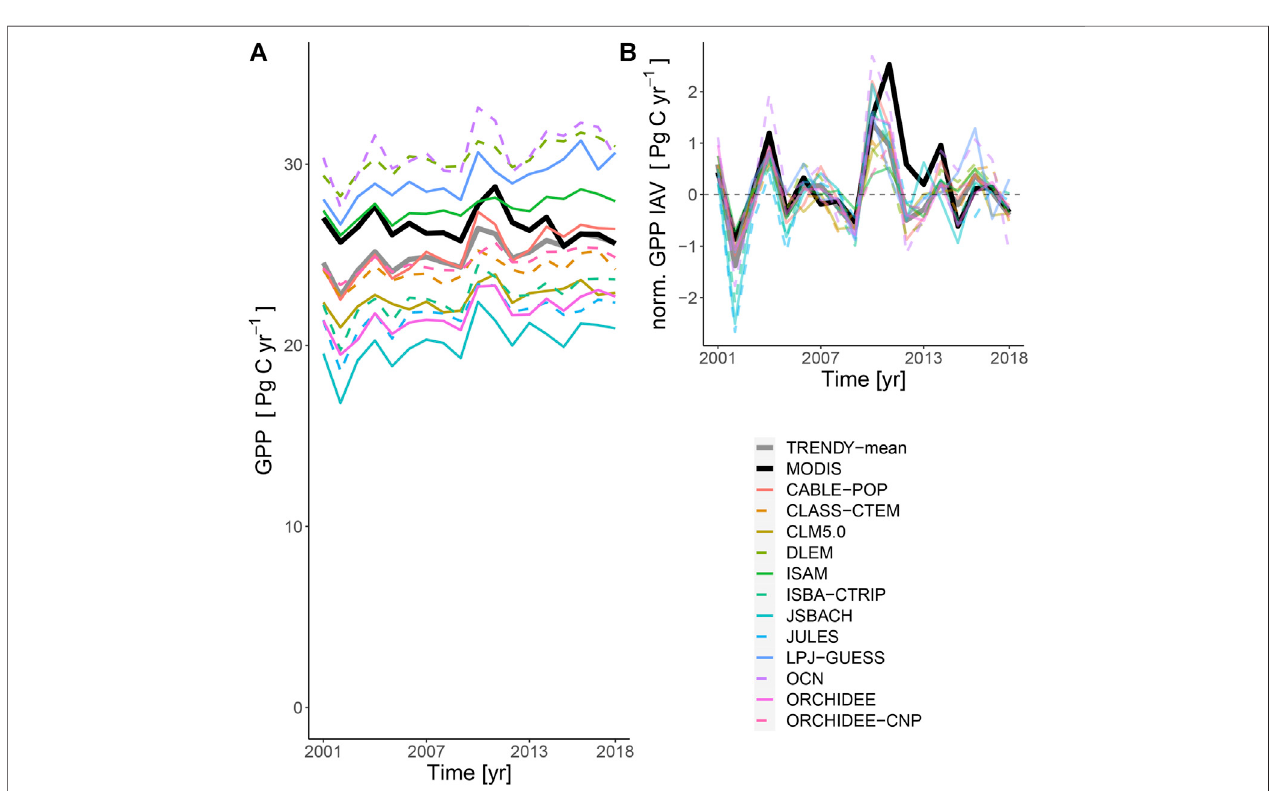
FIGURE 3 | (A) Time-series of mean annual GPP (2001 – 2018) of global drylands for the satellite retrieval and TRENDY models (including TRENDY mean). All 12 models simulateincreasingGPPovertime whereasMODIS-retrieved GPPhadnocleartrend. (B) Themean-normaliseddetrendedtimeseries showgoodagreement in interannual differences for all